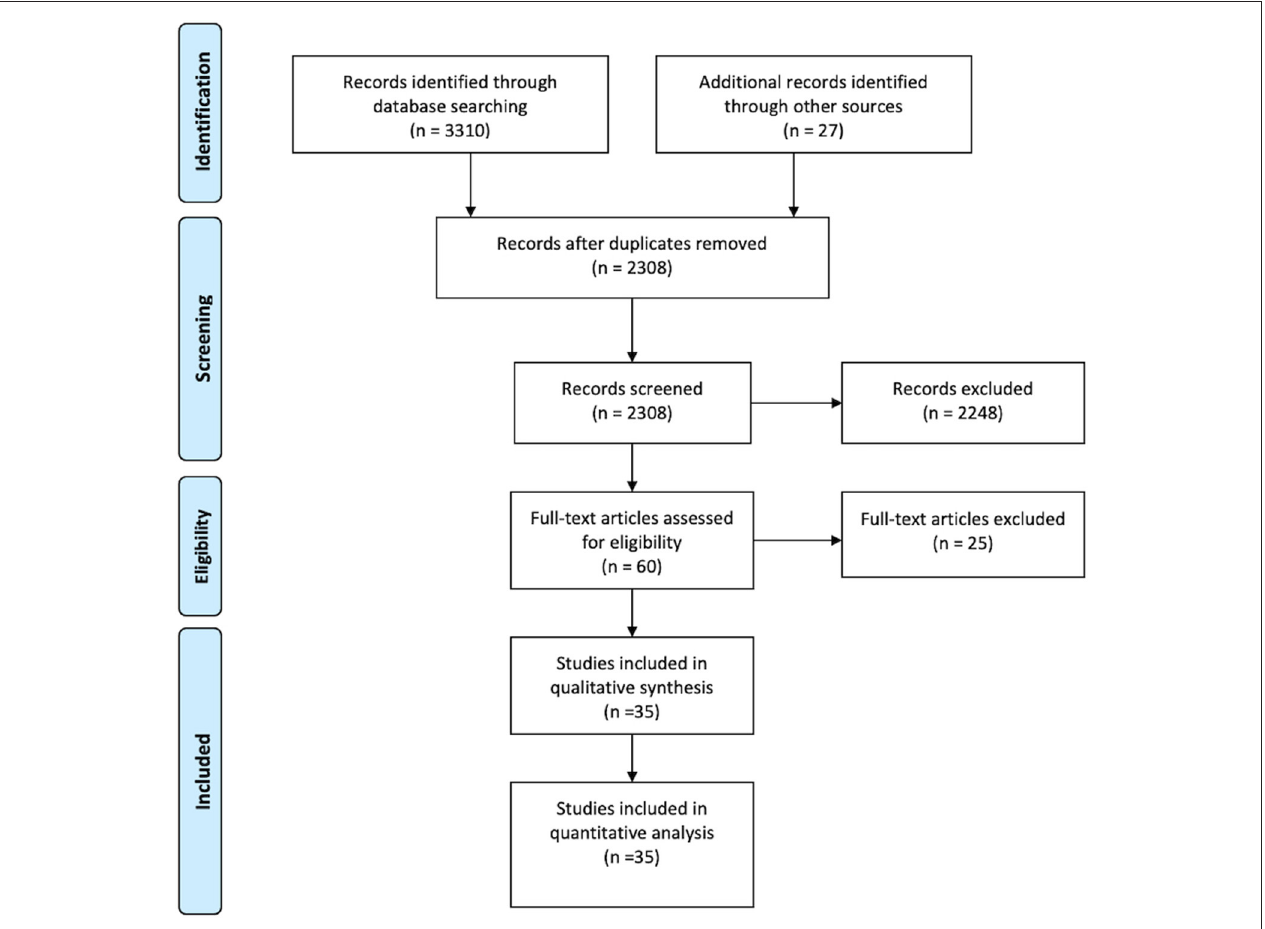
FIGURE 1 | Screening flow